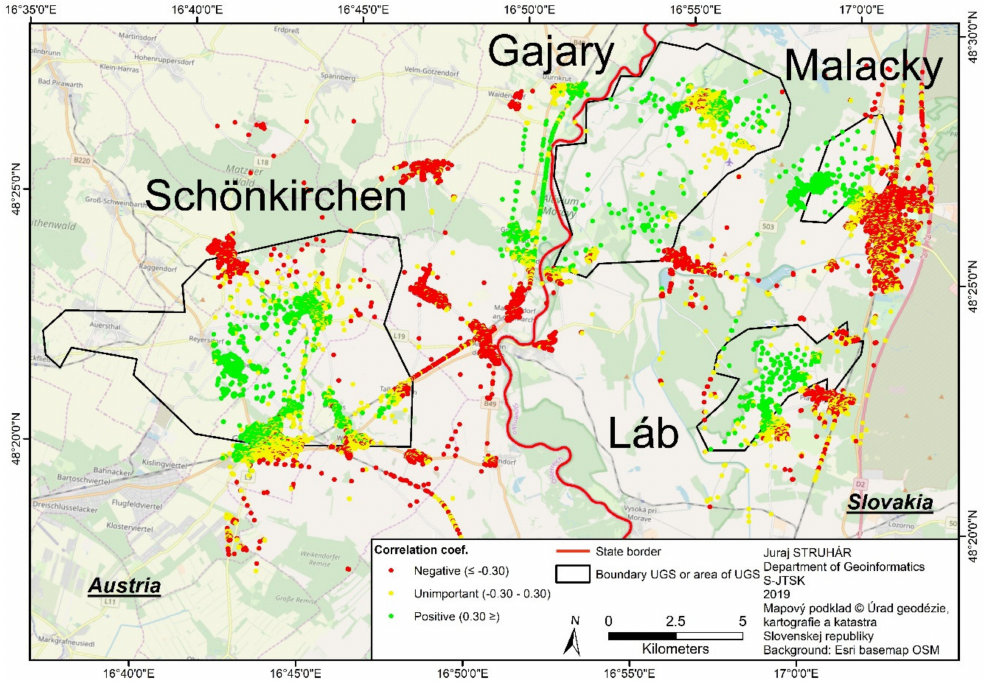
Figure 9. Example of the spatial distribution of correlation coe ffi cient r (computed for every PS point) in the Vienna Basin in the UGS area in Slovakia and Austria.